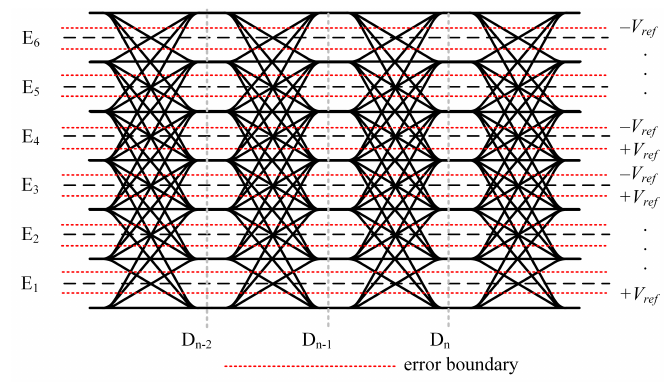
Figure 9. DB PAM-4 error boundary and eye diagram relation.